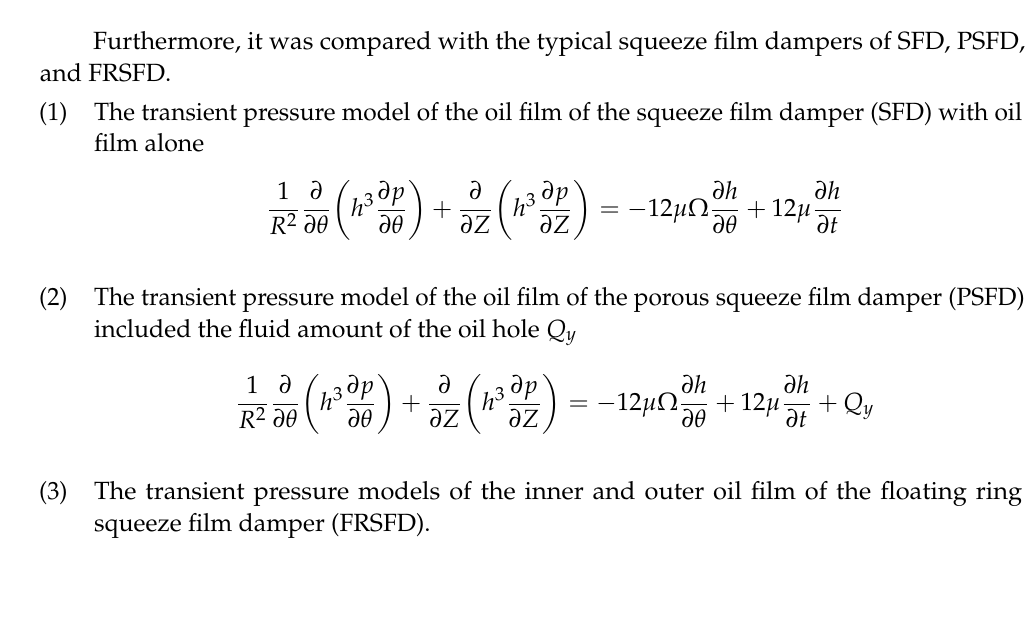
The transient pressure models of the inner and outer oil film of the floating ring squeeze film damper